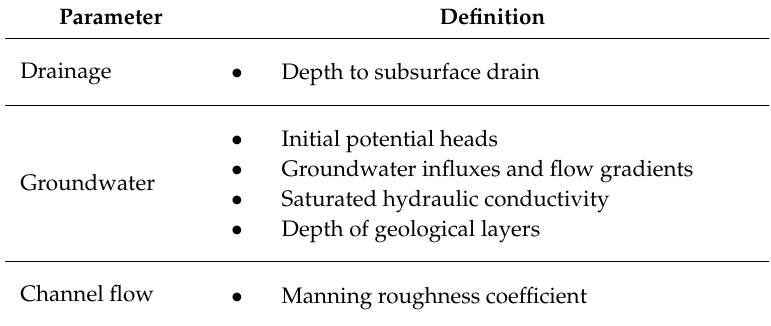
Table 4. Variables used for sensitivity analyses and their definitions in MIKE SHE and MIKE 11.